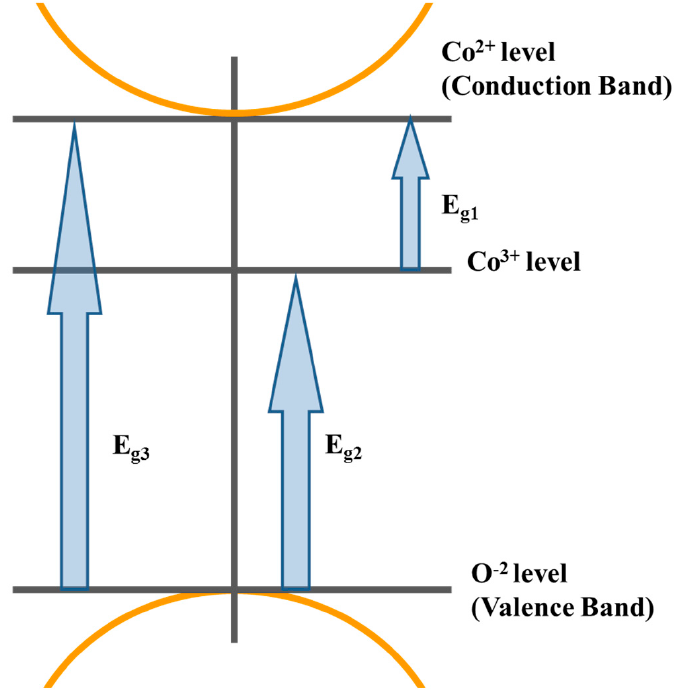
Figure 5. The proposed schematic diagram for the optical energy bands of spinel cobalt oxide .